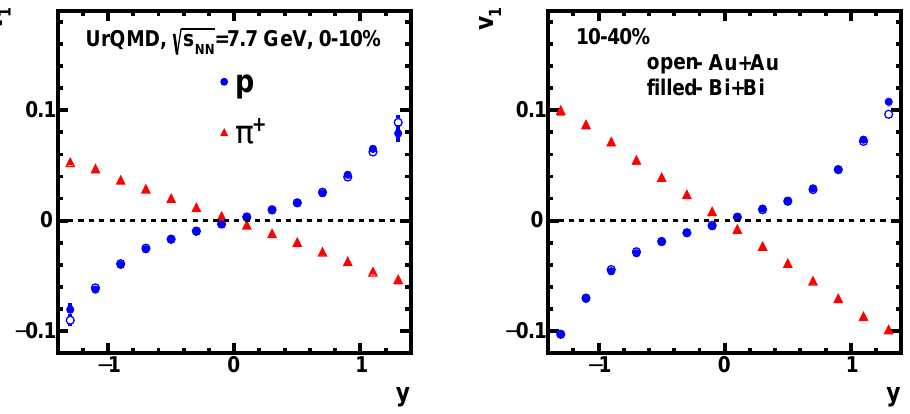
Figure 13. Rapidity y dependence of directed v 1 flow of charged pions and protons for 0–10% central ( left panel) and 10–40% central ( right panel) collisions at results for Au + Au and closed symbols for Bi + Bi collisions.